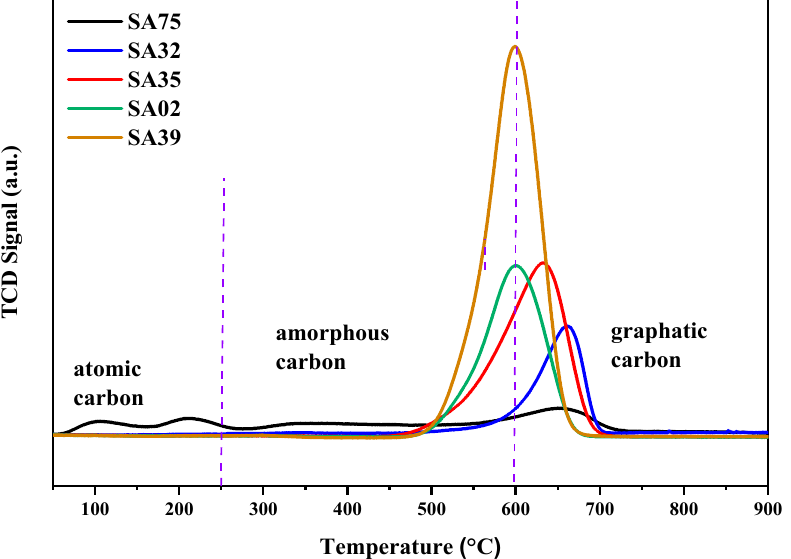
Figure 10. Temperature-programming oxidation of the used catalysts.